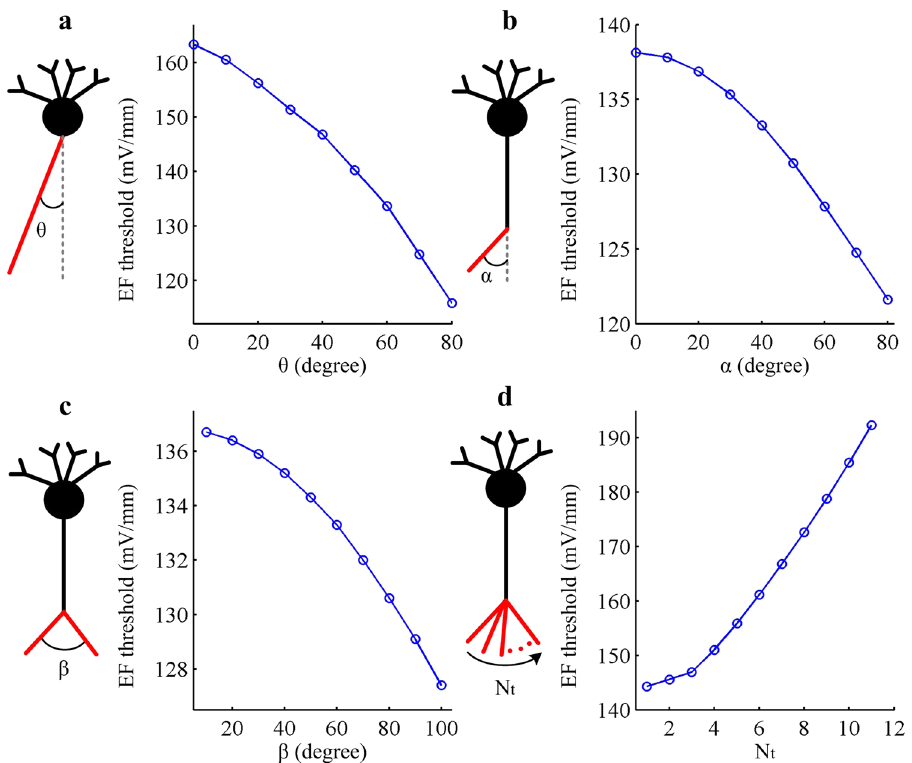
Figure 6. Basic morphologies of axon affect EF firing threshold in artificial model. (a) and (b) give the EF threshold as a function of two types of bend angle θ and α . (c) and (d) show the field threshold as a function of branch angle β and branch number N t of axon terminal. The diameter and length of each branch (indicated by red lines) in (b–d) are 2 μ m and 20 μ m, respectively. Other morphological and biophysical parameters of the artificial neuron are as described in